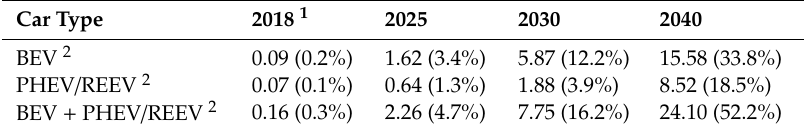
Figure 5. Yearly results of the simulation for 2019–2050: overall market share between conventional and electric cars. Table 2. Results of the simulation in million cars and share of the overall market.